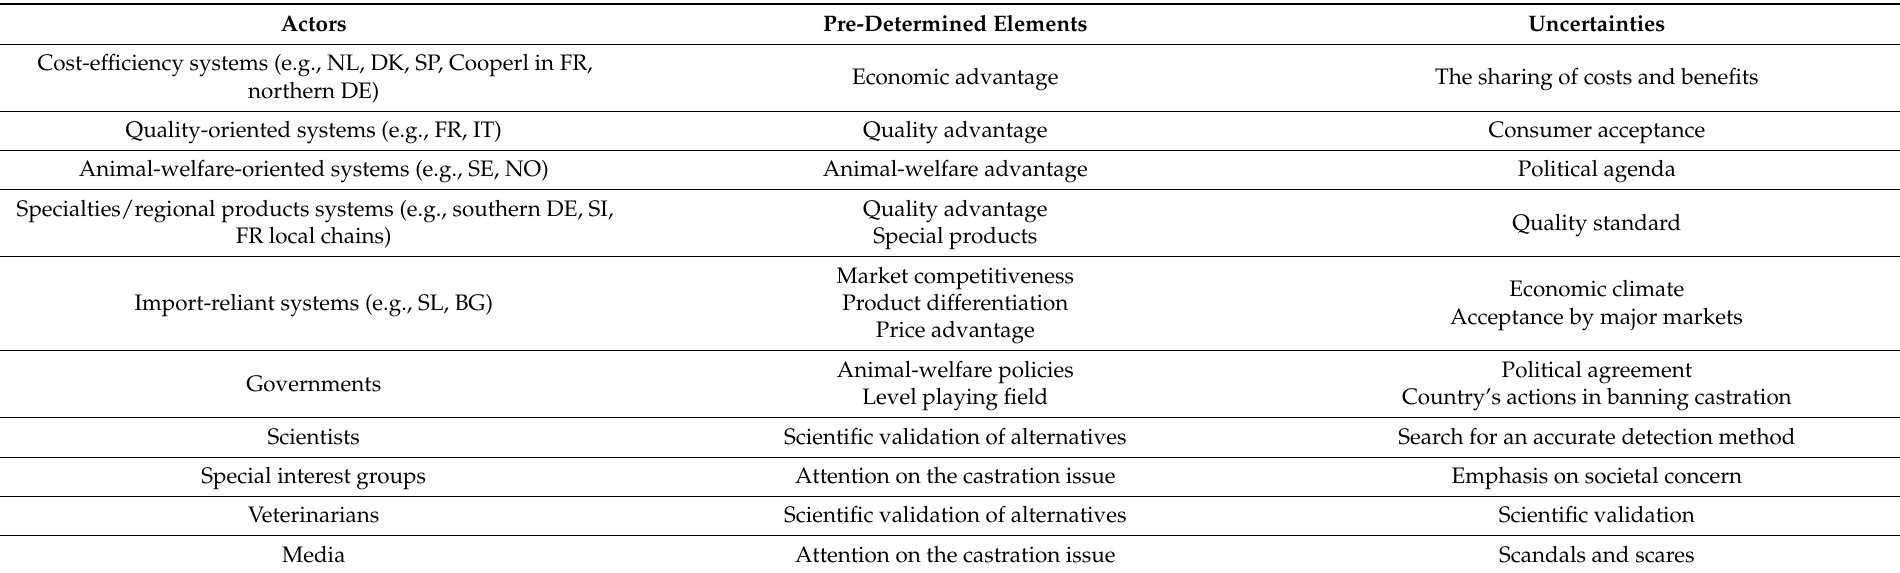
Table 1. Actors, pre-determined elements, and uncertainties included in the scenario analysis regarding future pig